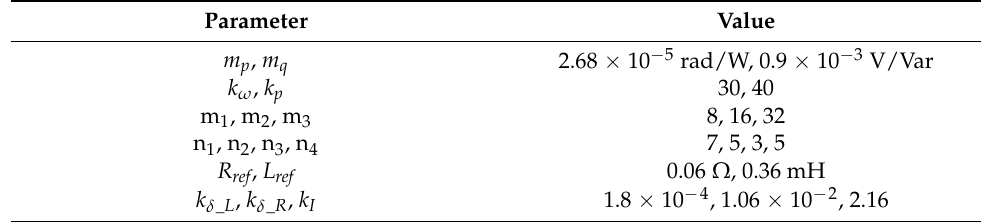
Table 3. Parameters of the proposed secondary controller.